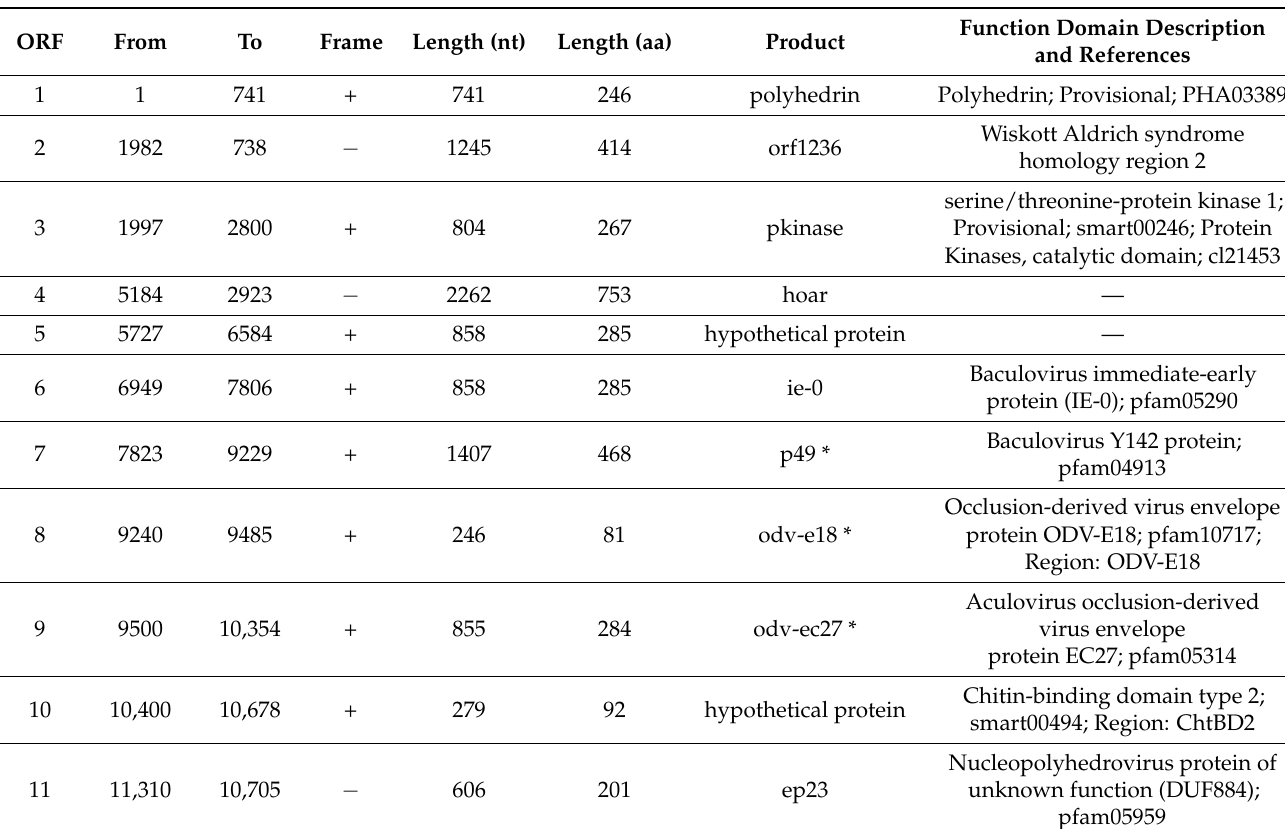
Table 1. ORFs identified in